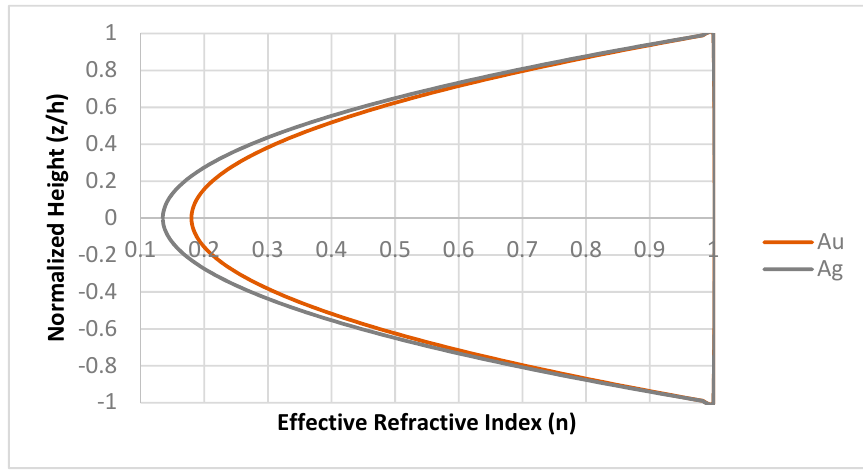
Figure 4. Normalized height vs. effective refractive index for both Au and Ag nanospheres.